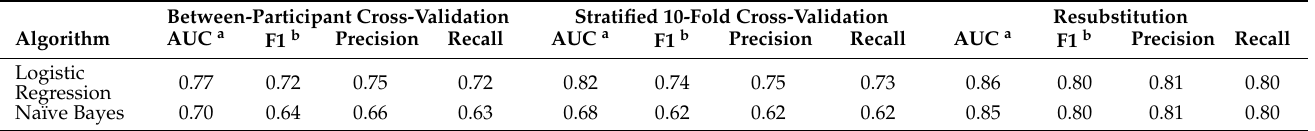
Table 3. Performance of logistic regression and naïve Bayes algorithms for prediction of flow.